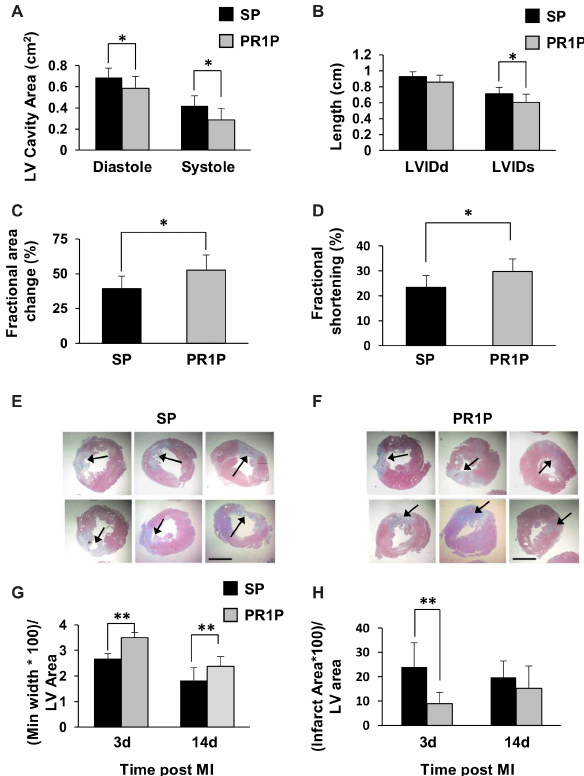
Figure 2. PR1P enhances the functional outcome of the heart following myocardial infarction in rats. ( A – D ) Bar graphs showing echocardiographic assessments of rat heart function at 14 days following left anterior coronary artery ligation and every other day treatment with PR1P or scrambled peptide (SP) indicating improved outcome following PR1P treatment. Left ventricular cavity area (LV cavity area), left ventricular internal diameter at end diastole (LVIDd), left ventricular internal diameter at end systole (LVIDs) and fractional shortening (FS). ( n = 9 PRIP, 7 SP) * p <0.04, ( E – H ) PR1P reduces infarct size following ischemia. ( E , F ) Representative photomicrographs of Masson trichrome stained sections of rat heart from animals described in Figure 2A indicating infarcted regions (collagen, blue) and regions with viable muscle (pink red) at 14 days after surgery. Black arrows indicate areas of infarction. Scale bar, 100 mm. ( G , H ) Bar graphs showing quantification of infarct size from photomicrographs described in E–F from hearts prepared 3 ( n = 5 PR1P, 5 SP) and 14 ( n = 6 PR1P, 5 SP) days after surgery. ** p <